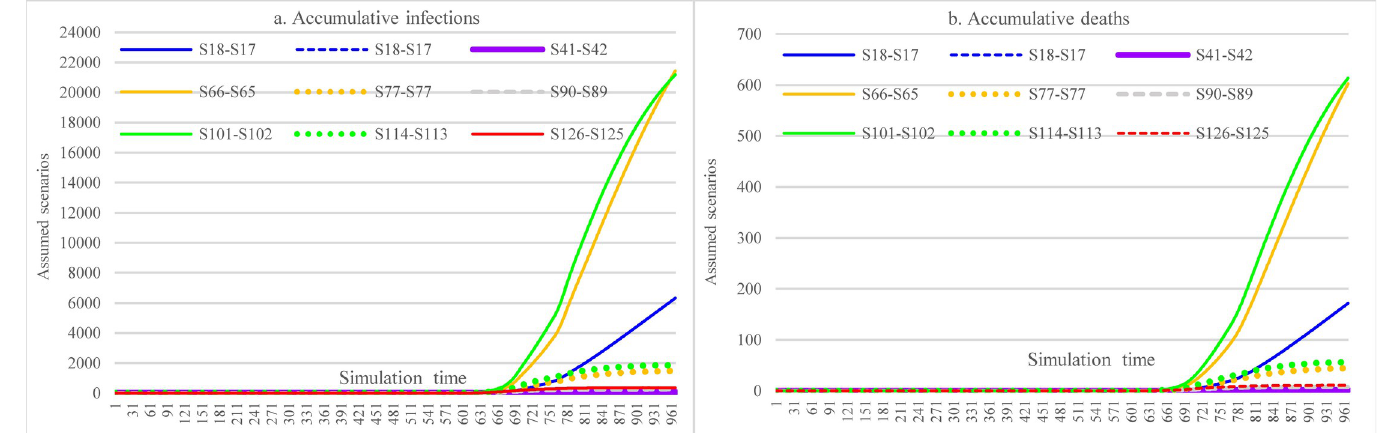
Fig 13. Impacts of vaccine efficacy on COVID-19 spread considering mask-wearing adherence and increasing vaccination capacity.